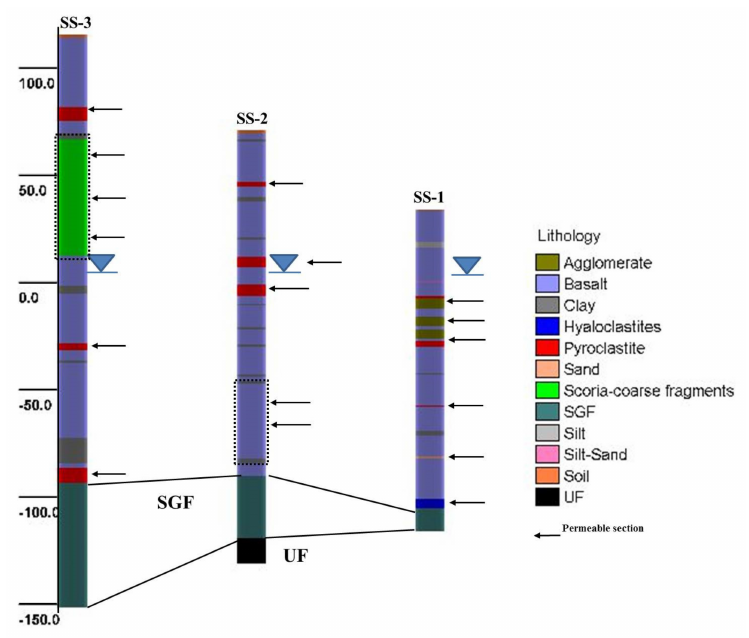
Figure 2. Lithology logs with the permeable sections in wells SS-1, SS-2, and SS-3.